Question: Name the type of graph shown.
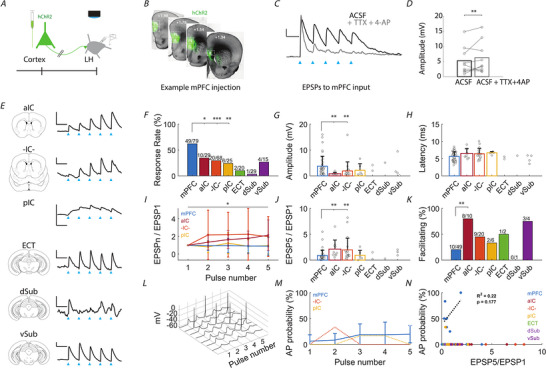
Answer: scatter